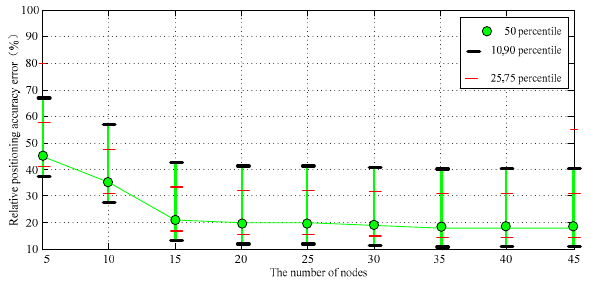
Figure 12. The confidence interval of the data III.